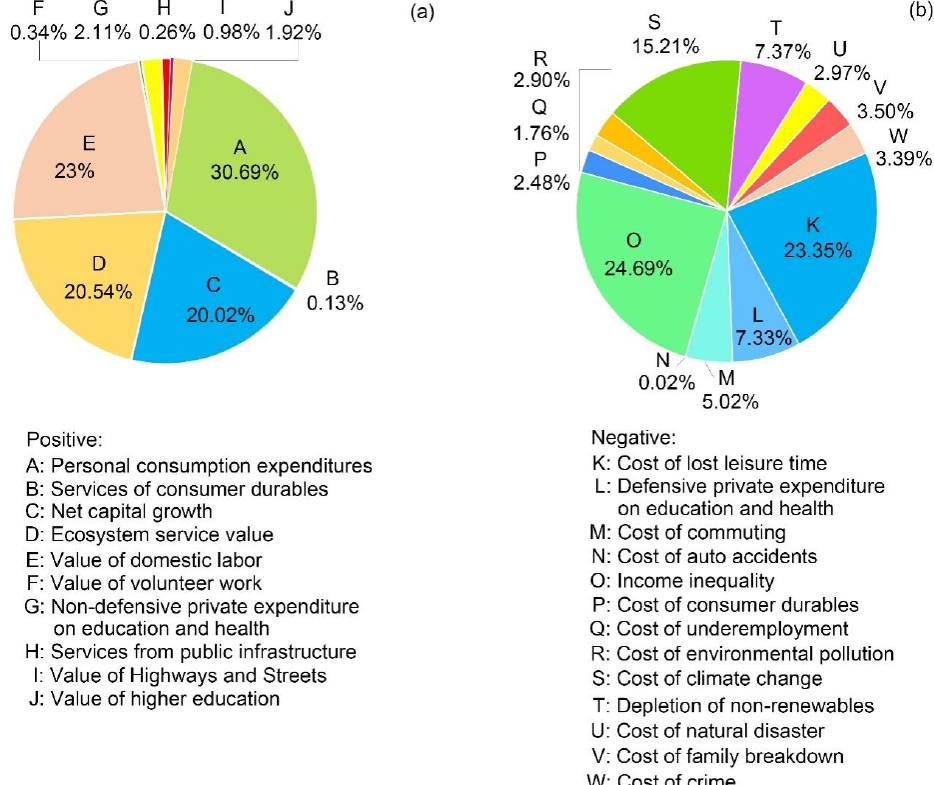
Figure 4. Average contribution of social, economic, and ecological indicators to total GPI from 1995 to 2017. ( a ) Average contribution of all positive indicators to total GPI; ( b ) Average contribution of all negative indicators to total GPI.